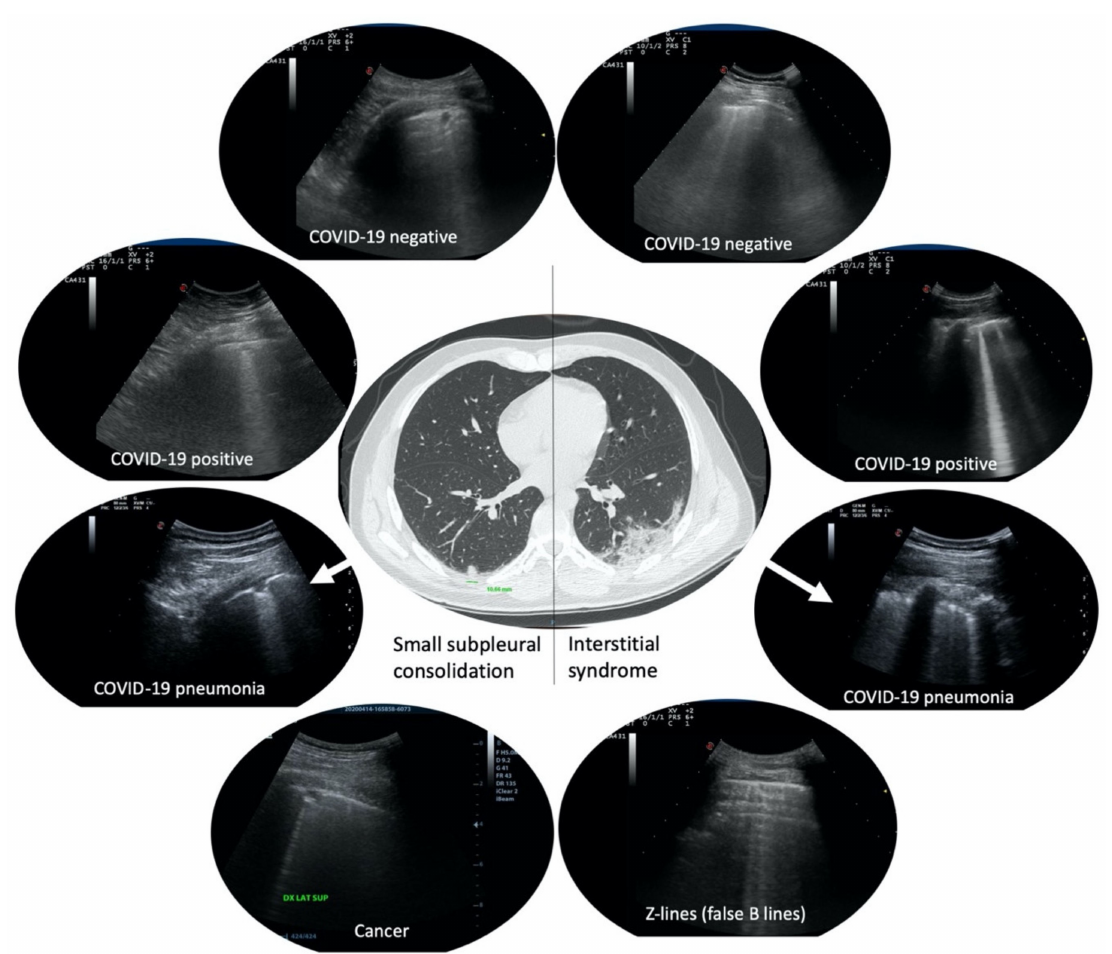
Figure 1. Examples of small subpleural consolidations and group of B-lines more than three per field of scan. In the center, a computer tomography scan of a real COVID-19 patient presenting a small subpleural consolidation in the right lung (left of the image) and a ground-glass area in the left lung (right of the image), and their corresponding features in lung ultrasound (LU) (arrows). On the left, small subpleural consolidations in four different patients with different diagnoses. On the right, group of B-lines more than three per field of scan in four different patients with different